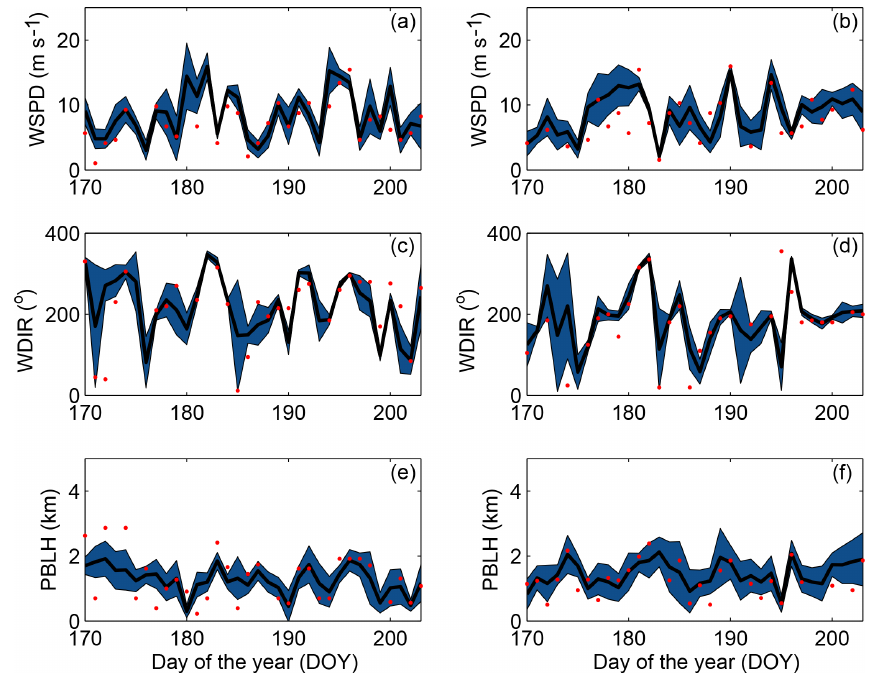
Figure 5. Time series of the simulated and observed for 300m wind speed (a, b) , 300m wind direction (c, d) and PBLH (e, f) at the GRB (a, c, e) and TOP (b, d, f) sites. The shaded blue area represents the spread (i.e., RMSD) of the full ensemble, the solid line is the ensemble mean, and the red dots are the observations at 00:00UTC.